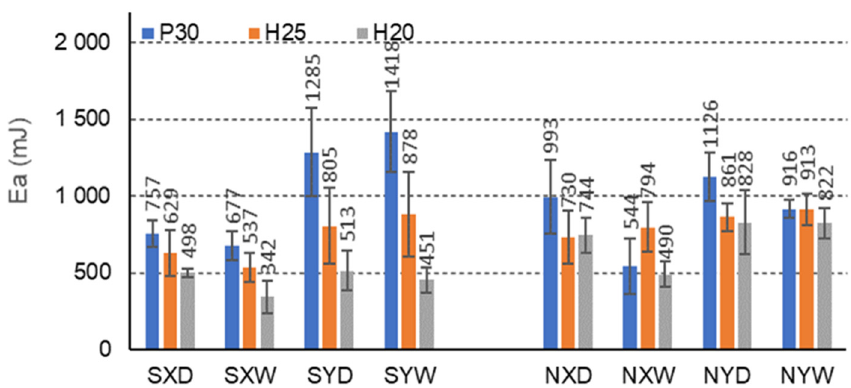
Figure 13. Illustration of the E a relationship of honeycomb panels with a core of C-cells. Whiskers represent standard deviations.